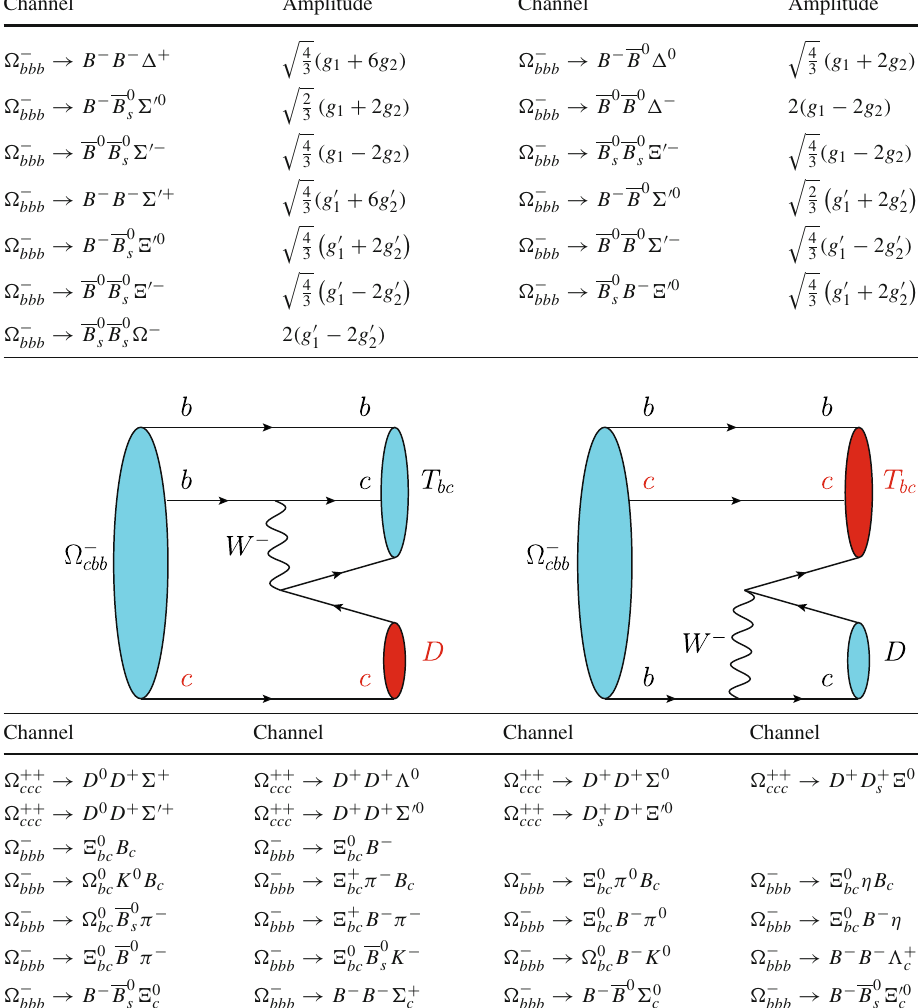
Table 8 Amplitudes for (cid:2) − Channel Amplitude Channel bbb decays into two B -mesons and a light baryon (decuplet)